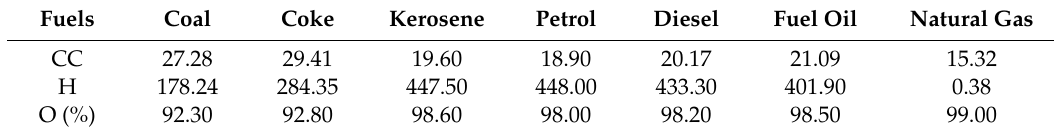
Table 1. Coe ffi cients of carbon emissions of di ff erent